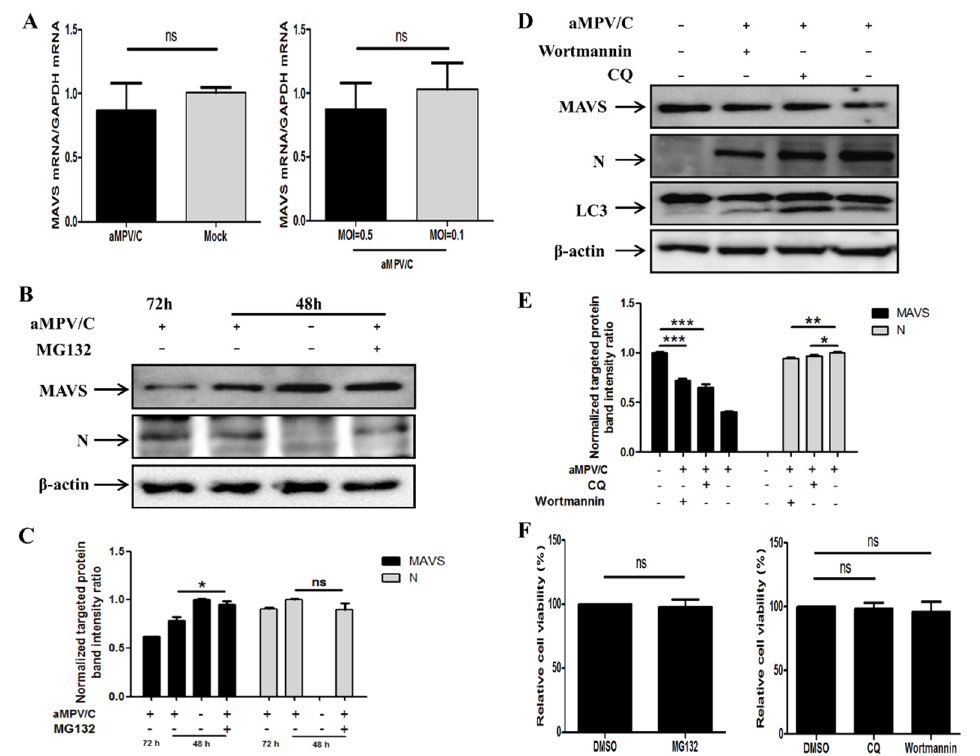
Figure 2. MAVS degradation is inhibited by MG132. ( A ) Total cellular RNA was extracted from aMPV/C-infected (MOI = 0.1 or 0.5) or mock-infected Vero cells at 48 h, and qRT-PCR was employed to analyze MAVS and GAPDH levels. ( B ) aMPV/C-infected (MOI = 0.5) or mock-infected Vero cells were treated with or without MG132 (10 μ M) for 12 h prior to cell harvesting at 48 or 72 hpi and protein levels of MAVS and N were detected. The presence of MG132 is indicated with “+.” ( C ) Representative results are displayed with graphs corresponding to the ratios of MAVS: β -actin or P: β -actin normalized to the control conditions. ( D ) aMPV/C-infected (MOI = 0.5) Vero cells were treated with CQ (20 µ M) or wortmannin (100 nM), harvested after 48 dpi, and analyzed as described in C. ( E ) Representative results are displayed with graphs corresponding to the ratios of MAVS: β -actin or N: β -actin normalized to the control conditions. ( F ) Then the cell viability upon pharmacological treatments was determined by the Enhanced Cell Counting Kit-8. Representative results are shown in a graph representing the percentage of relative cell viability. Error bars, mean ± SD of three independent experiments. ns (not significant) p > 0.05; * p < 0.05; ** p < 0.01; *** p < 0.001, compared with the control group.